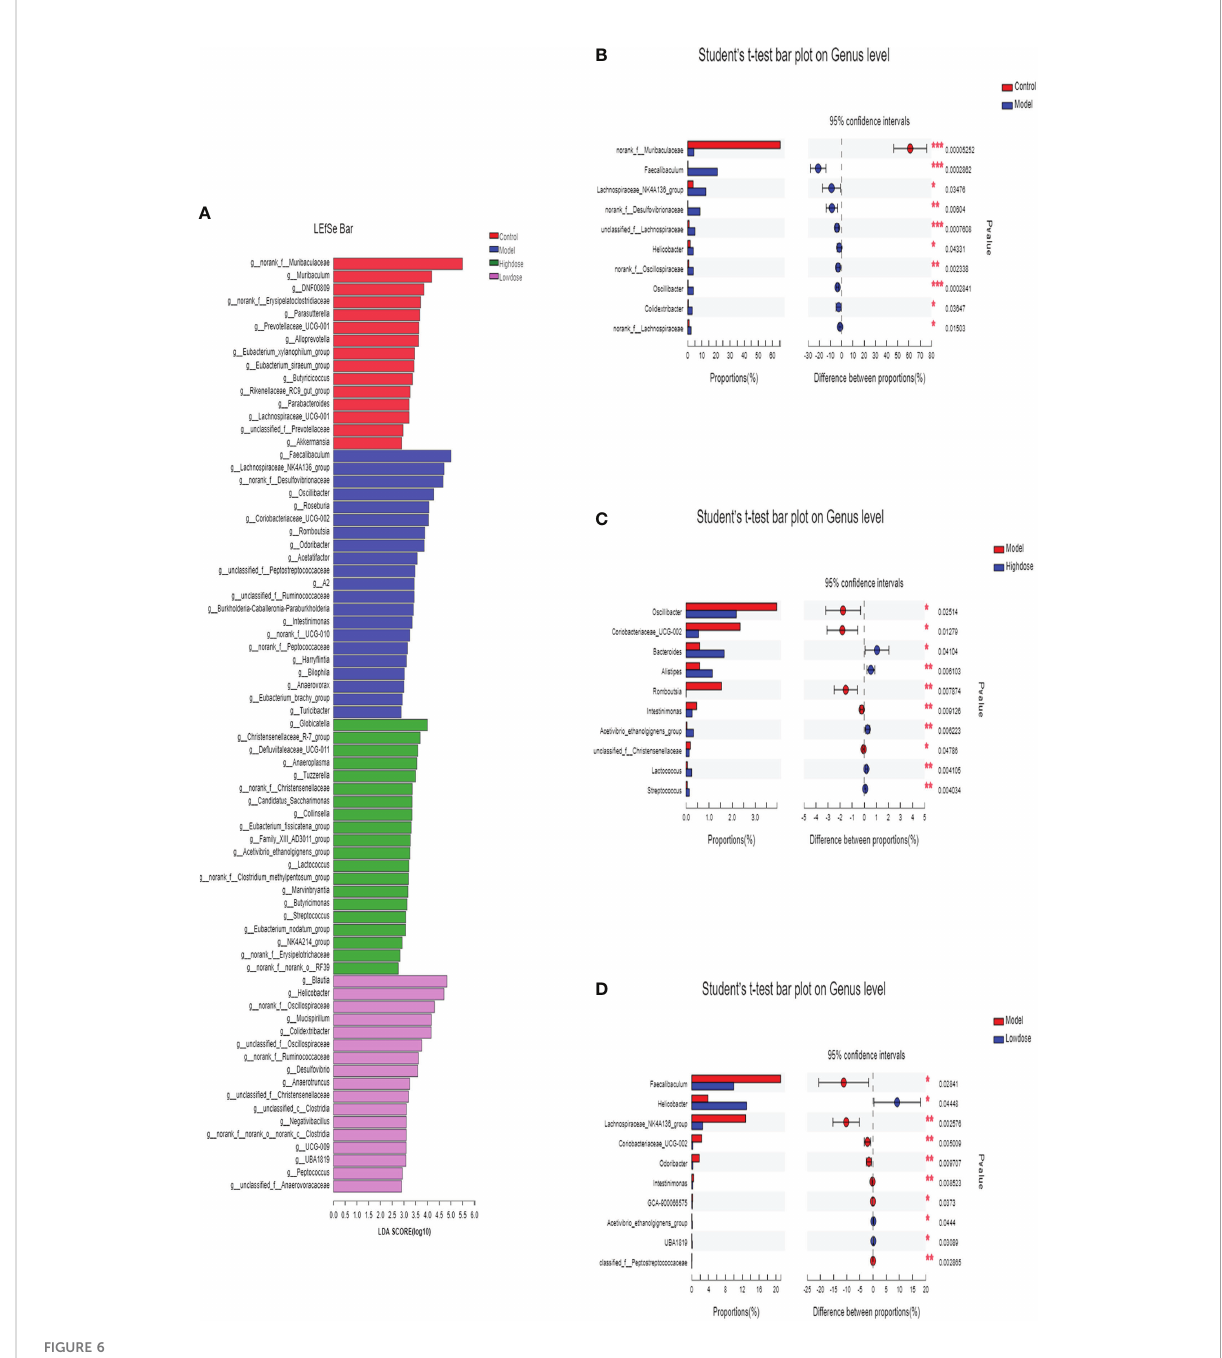
FIGURE 6 Differences of the microbiota genus in different groups. (A) LEfSe. Enriched taxa with an LDA score >2.0 was shown in the histogram. (B) Control (red) versus Model (blue). (C) Model (red) versus High-dose (blue). (D) Model (red) versus Low-dose (blue). *P < 0.05 , **P < 0.01 and ***P